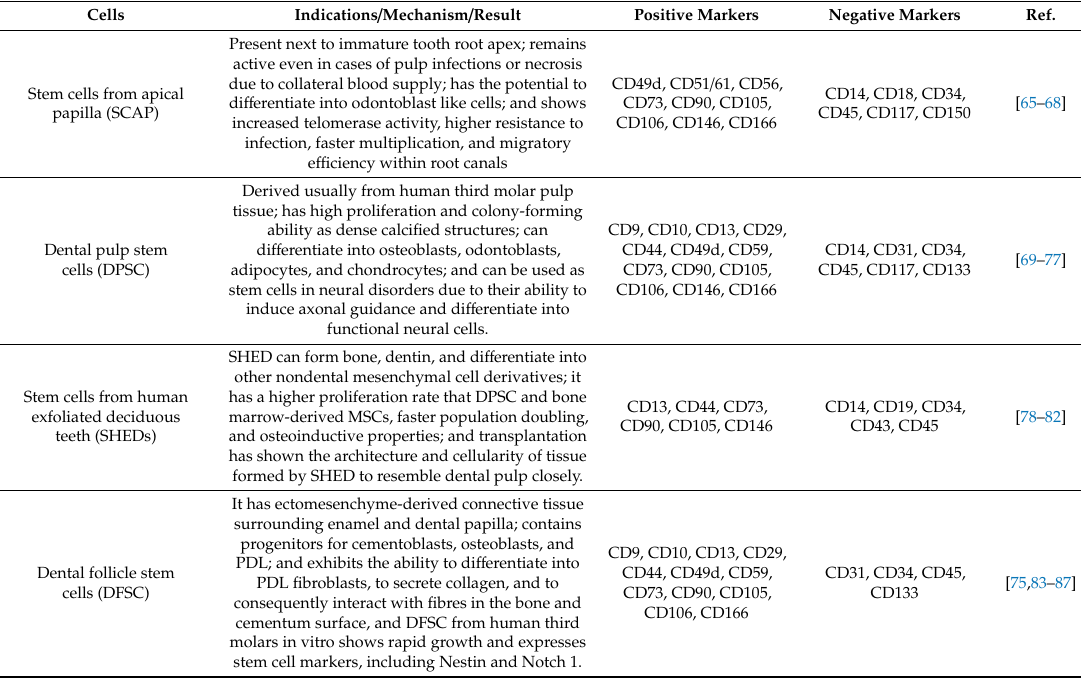
Table 4. Cell-based therapies for dentin pulp complex regeneration (cell transplantation strategies). Cells